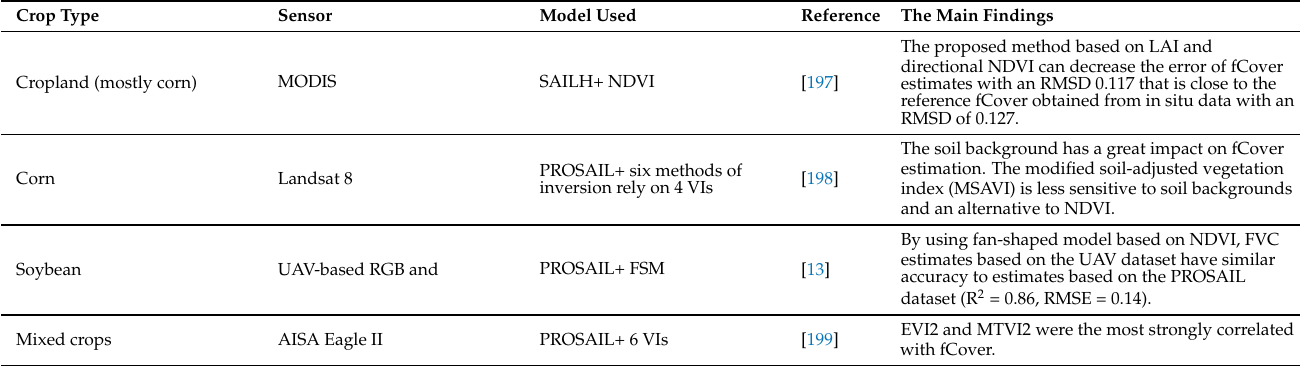
Table A2. Summary of fCover prediction using a parametric method.